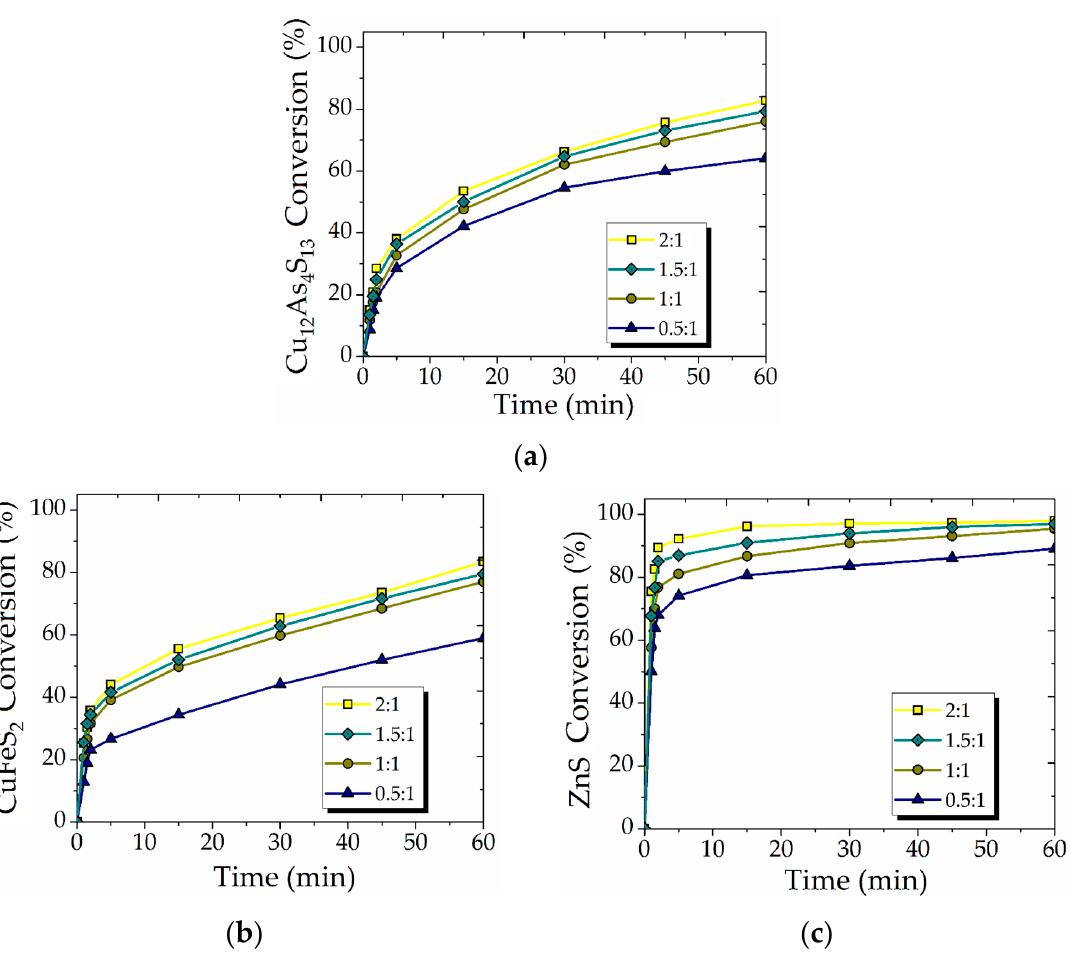
Figure 5. The effect of FeS 2 additive on the conversion of Cu 12 As 4 S 13 ( a ), CuFeS 2 ( b ) and ZnS ( c ) (300 rpm; 353 K; 6 mol/L HNO 3 ; 0.018 mol/L Fe (III)).